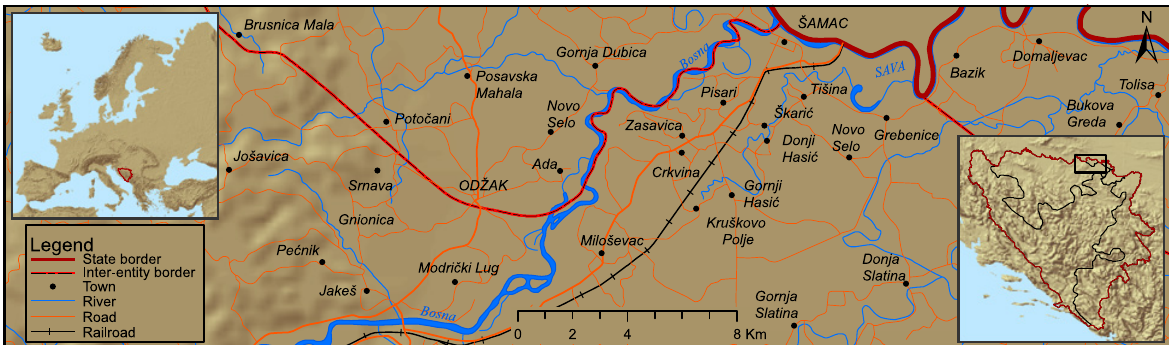
Fig. 1. Location of the study area – lower reach of the Bosna